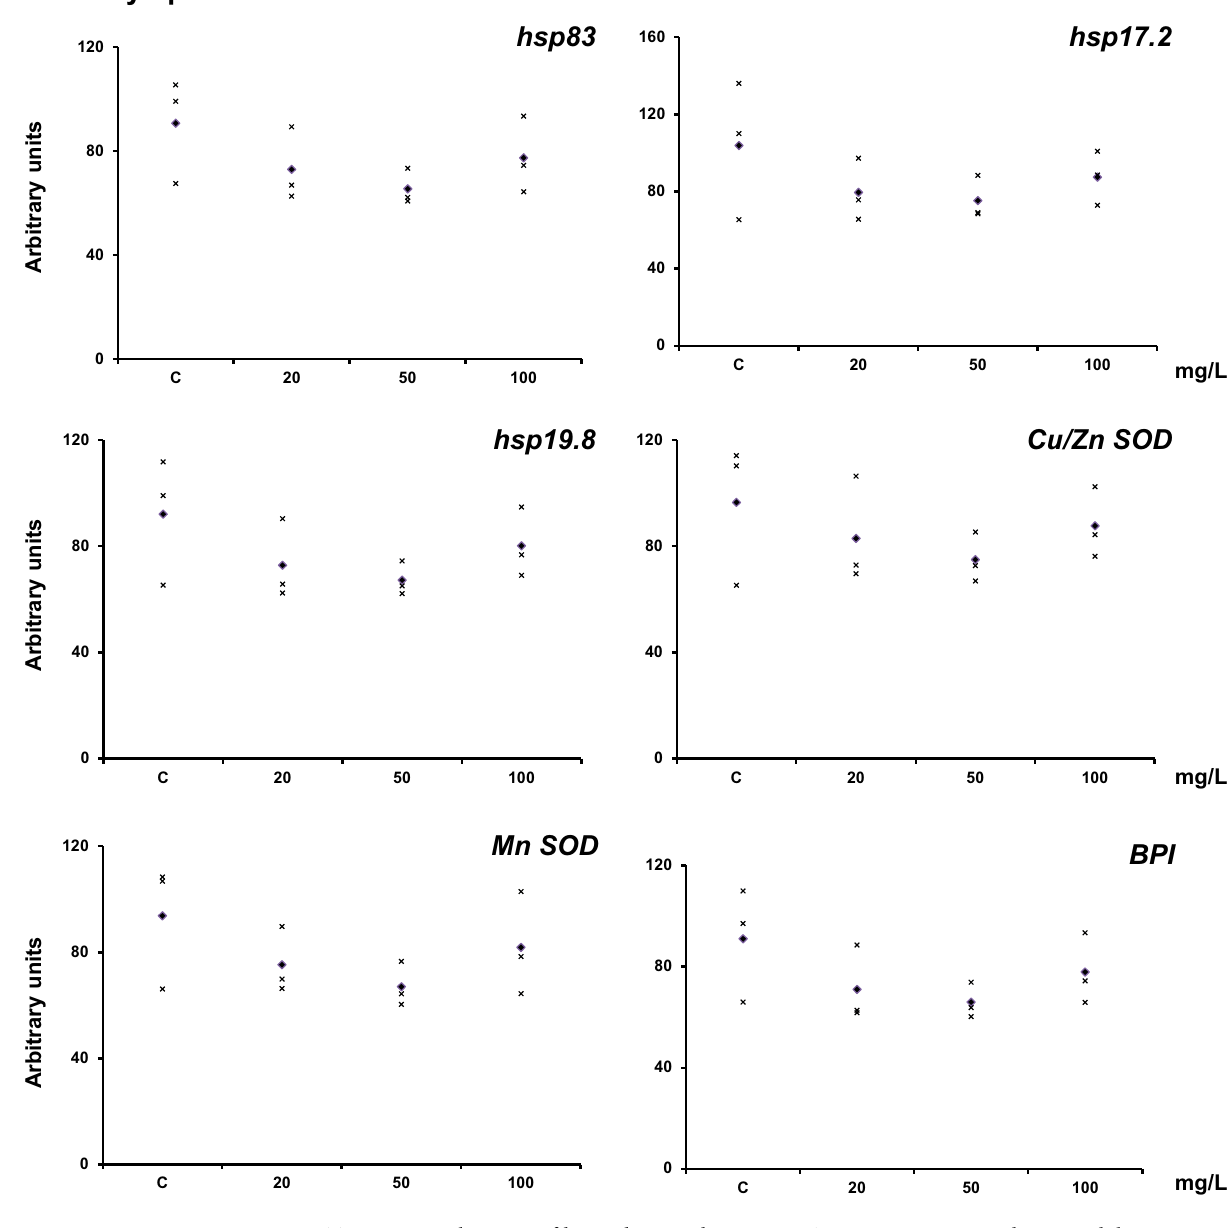
Figure 2. Transcriptional activity of hsp83 , hsp17.2 , hsp19.8 , Cu–Zn SOD , Mn-SOD , and BPI in adult H. aspersa hemolymph samples after in vivo exposure to Ag-NPs at (20 ± 2 °C) for 7 days. Animals were fed with lettuce soaked for one hour with the concentrations of silver nanoparticles indicated on the x-axis. Levels of mRNA were normalized using GAPDH as the reference gene. Three experiments were carried out, and the data are shown for each experiment (x). The diamond indicates the mean. The figure was drawn with Excel (Microsoft,